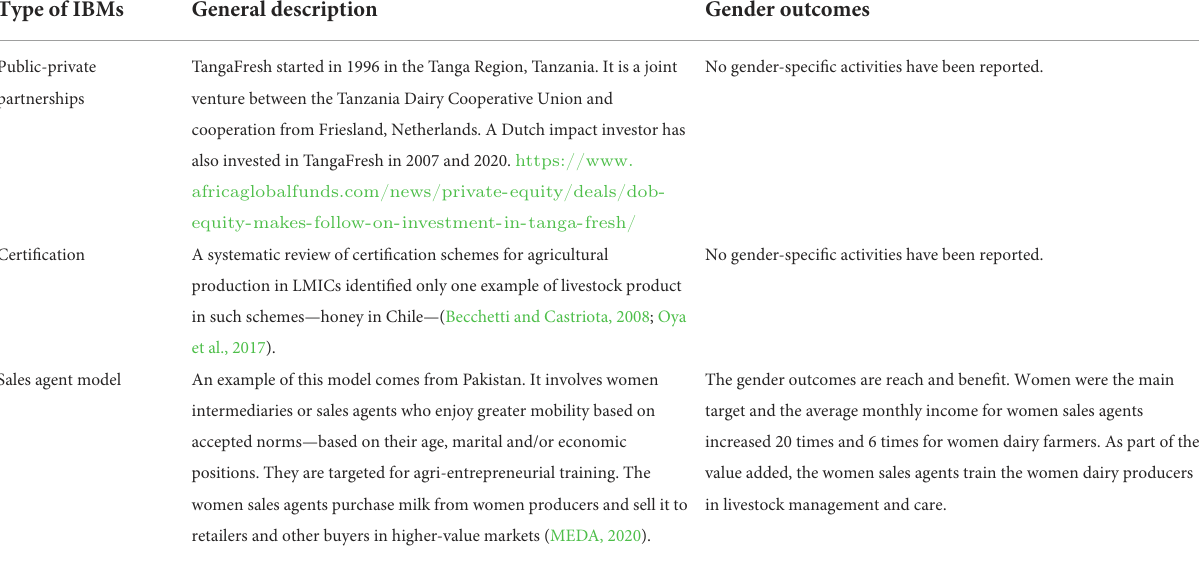
TABLE 1C Examples of intermediary-driven gender-inclusive business models, and reported gender